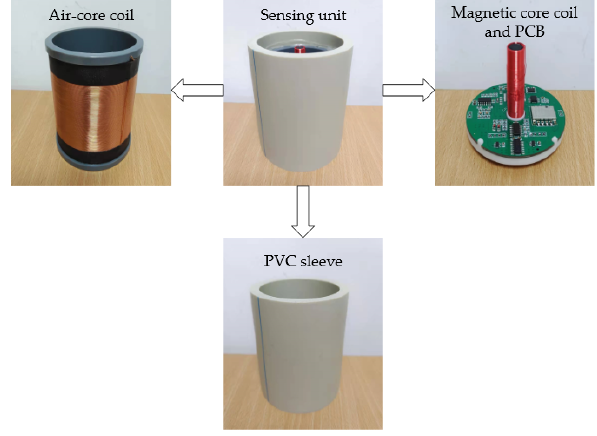
Figure 2. Schematic diagram of the structure of the sensing unit.